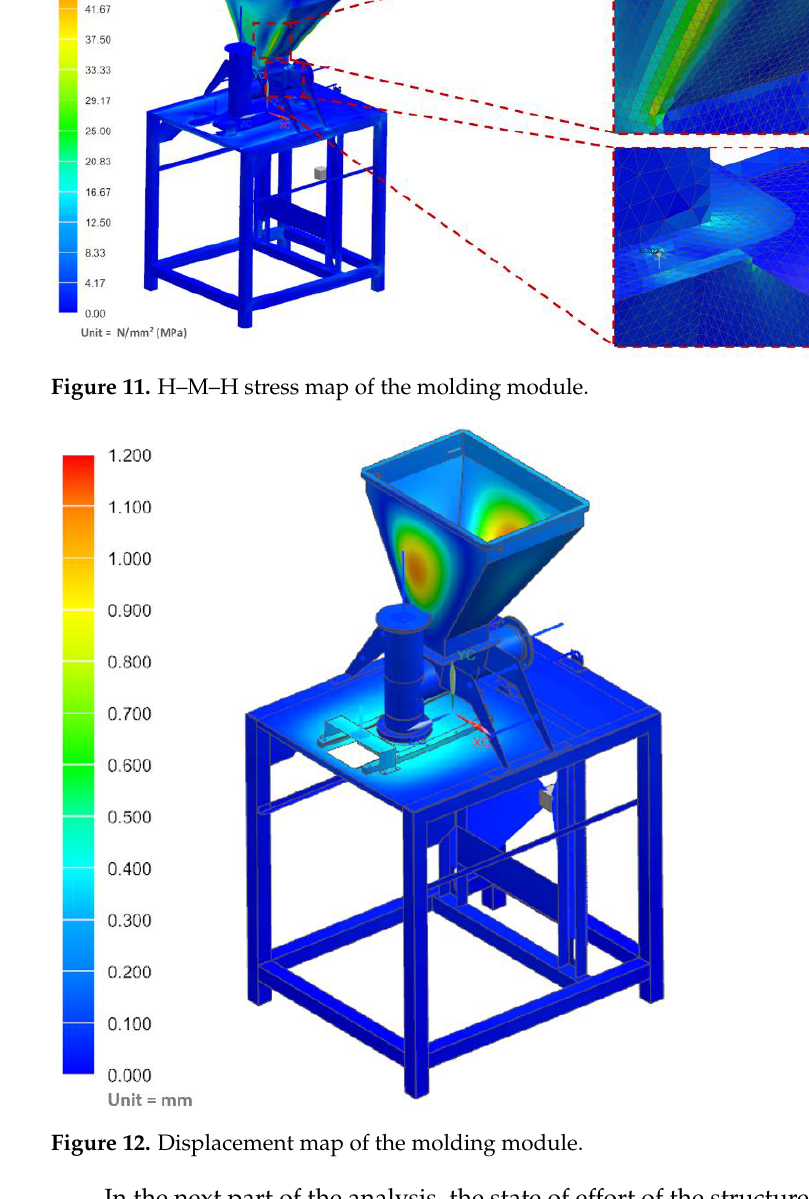
Figure 13. H–M–H stress map of the molding module: pusher of the horizontal dispenser is blocked.